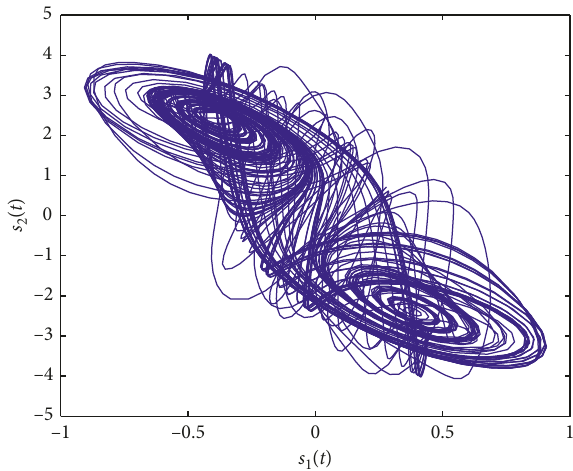
Figure 1: Chaotic attractor of s ( t ) .